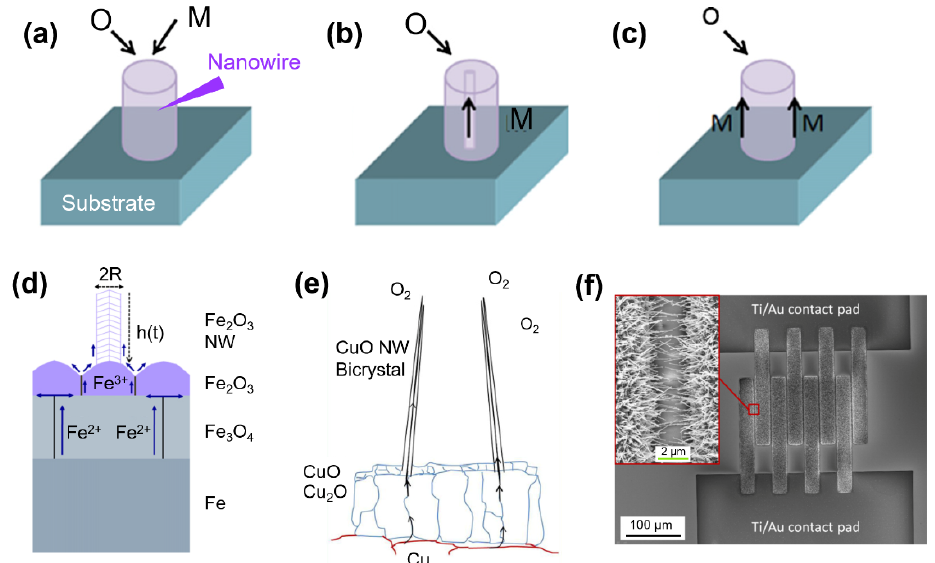
Figure 7. The various mechanisms proposed for metal–oxide nanowire (NW) growth during the oxidation of metal: ( a ) evaporation and condensation; ( b ) internal diffusion along with the core of a screw dislocation; ( c ) surface diffusion along the sidewall of nanowires; ( d ) Fe 2 O 3 nanowire growth following the surface diffusion mechanism. Reprinted with permission from Reference [181] Copy- right 2012 Elsevier; ( e ) CuO nanowire growth follows the internal diffusion mechanism. Reprinted with permission from Reference [189] Copyright 2011 Elsevier; and ( f ) CuO nanowire device fabri- cated by thermal oxidation method. Reprinted with permission from Reference [177] Copyright 2012 Elsevier.